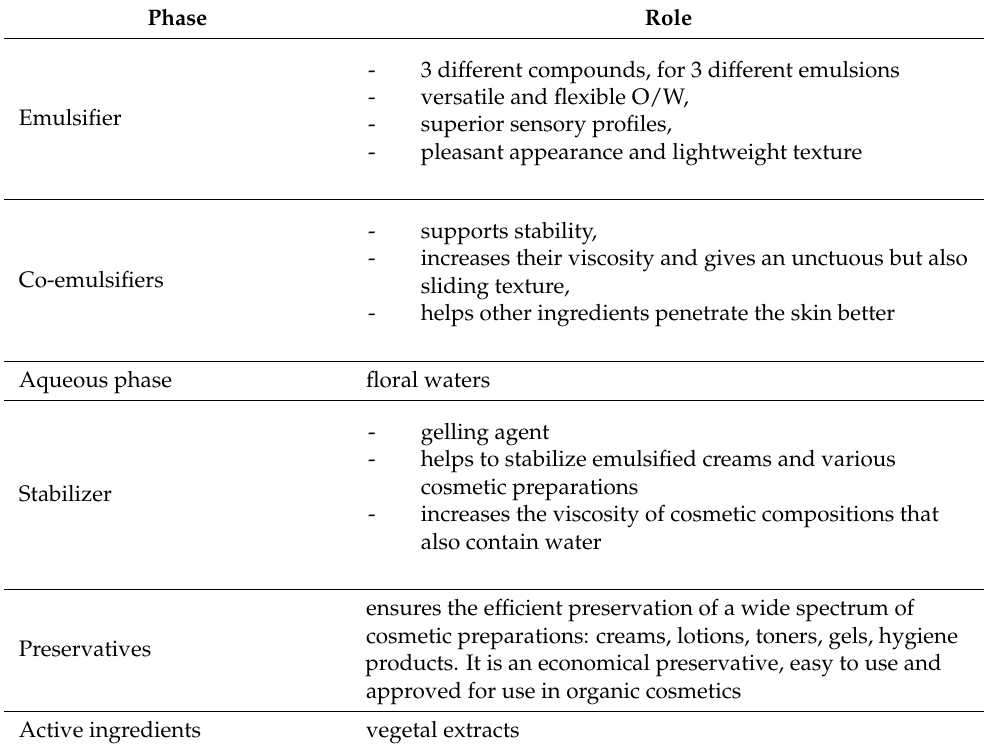
Table 6. The main ingredients for the formulation of